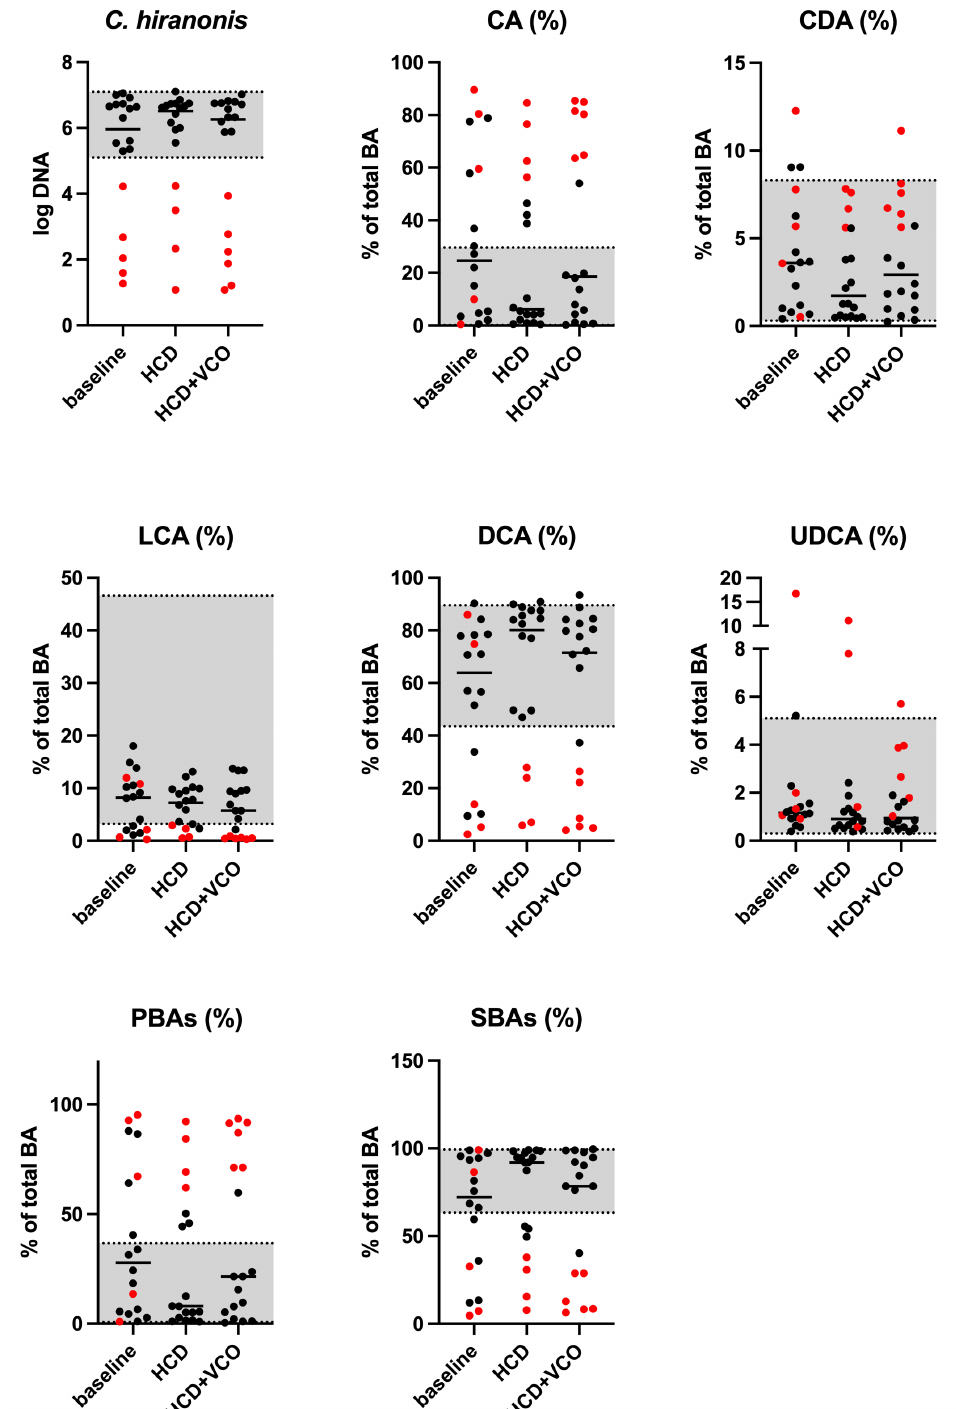
Figure 1. Dot plots showing the abundance of C. hiranonis (log DNA) and concentrations of the bile acids (BA, % of total) in canine fecal samples collected from dogs during the first visit (baseline), after receiving a home-cooked diet for 7 days (HCD), and after supplementation with virgin coconut oil (HCD + VCO). The black horizontal line represents the median. The grey shaded area corresponds to the internal reference intervals established for healthy dogs. The red dots represent dogs with low C. hiranonis abundance, while the black dots represent dogs with normal C. hiranonis